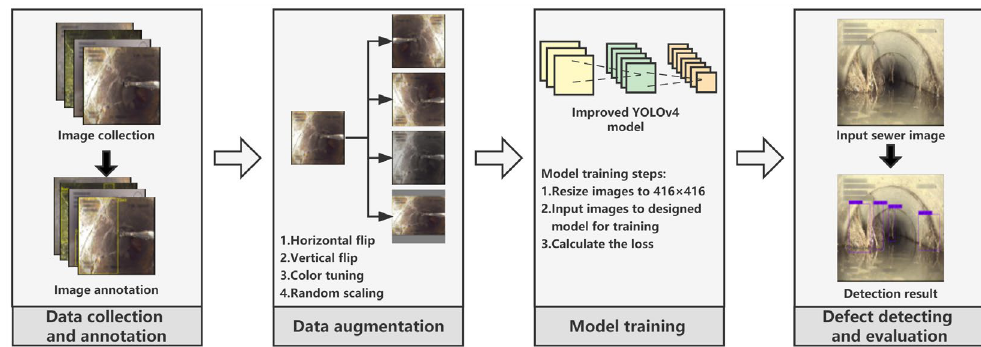
Figure 1. Overall workflow of this study .